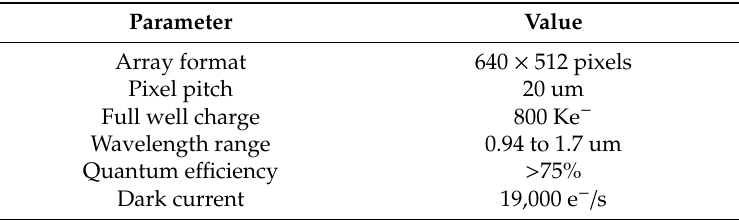
Table 1. Parameters of the shortwave infrared (SWIR) image sensor.